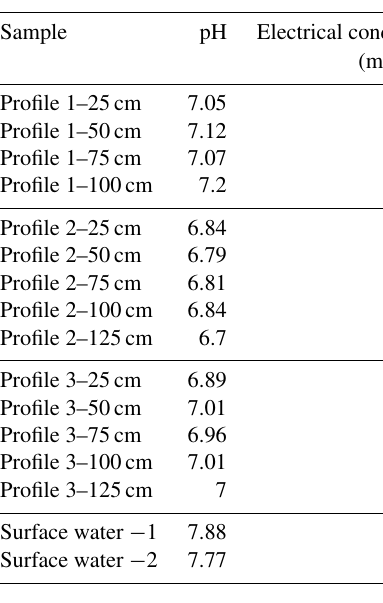
Table 1. Field parameters collected in porewater and surface water in the intertidal